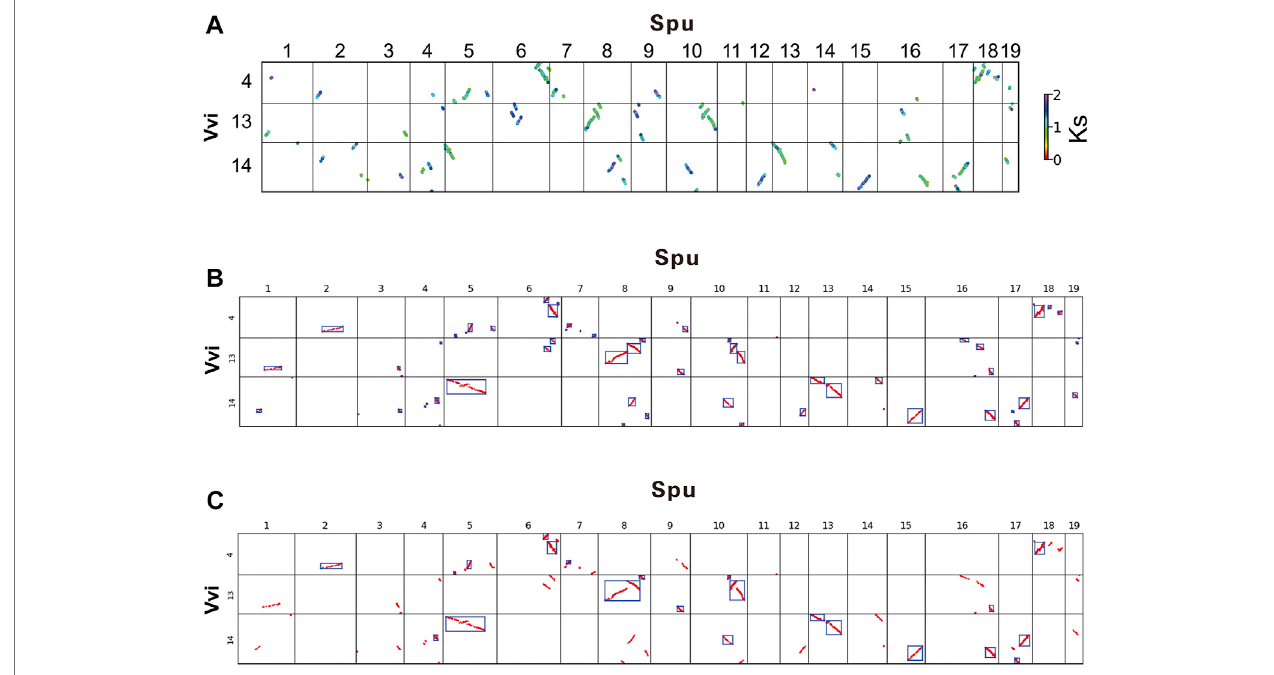
FIGURE 1 | (A) K S dotplot between Salix sinopurpurea and Vitis vinifera genome homologous genes (B) DBSCAN cluster recognition effect fi gure (C) Automatic label result of collinearity fragments based on DBSCAN.